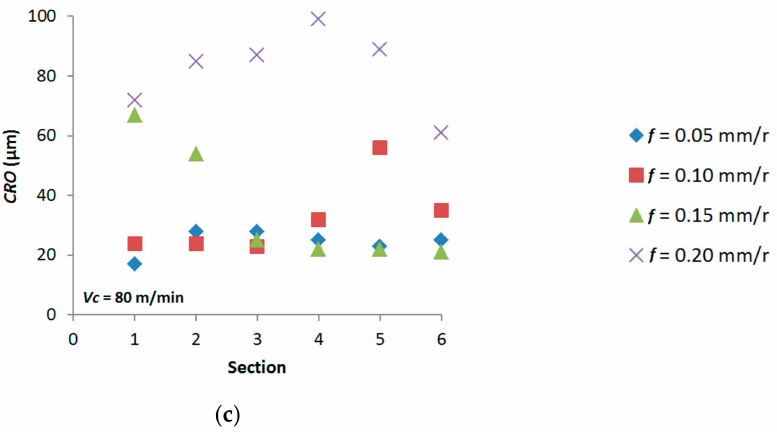
Figure 10. Circular run-out deviations for ( a ) v c = 40 m / min, ( b ) v c = 60 m / min and ( c ) v c = 80 m / min.